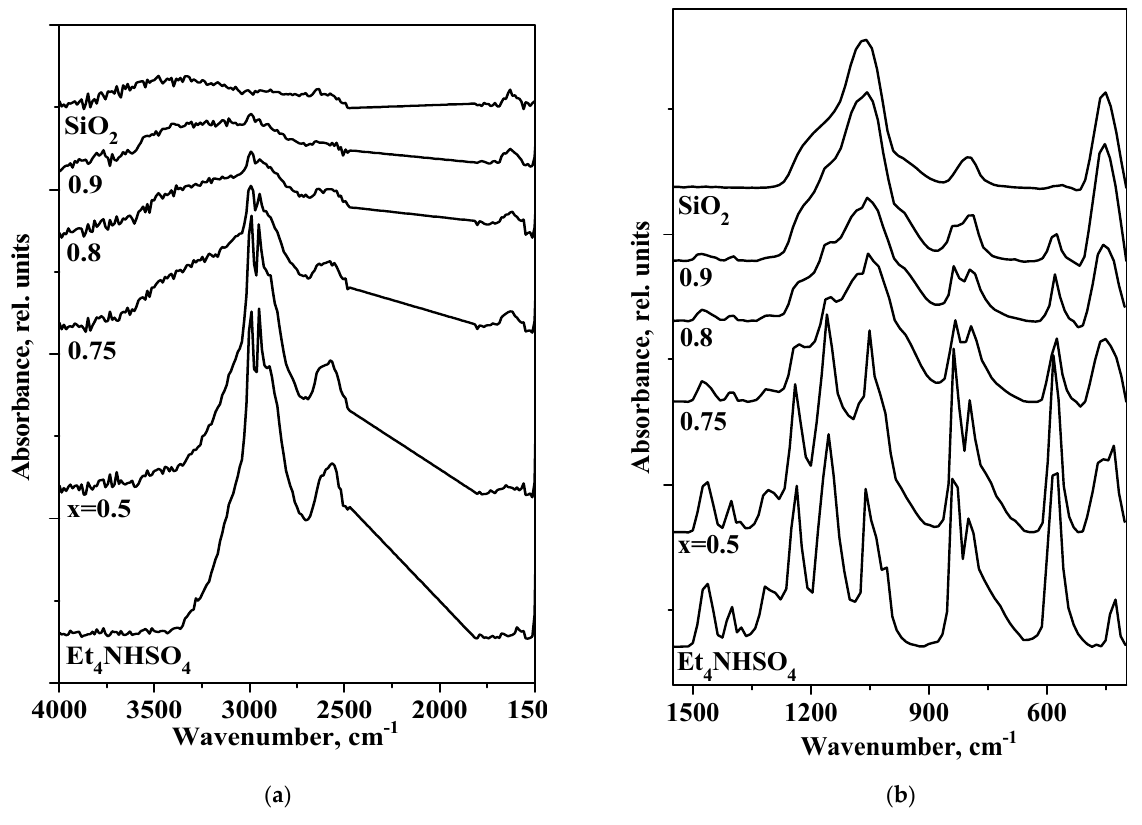
Figure 6. FTIR spectra of Et 4 NHSO 4 , SiO 2 and (1 − x)Et 4 NHSO 4 − xSiO 2 composites of different compositions presented in different spectral ranges: hydrogen bond network ( a ) and sulfate groups ( b ).